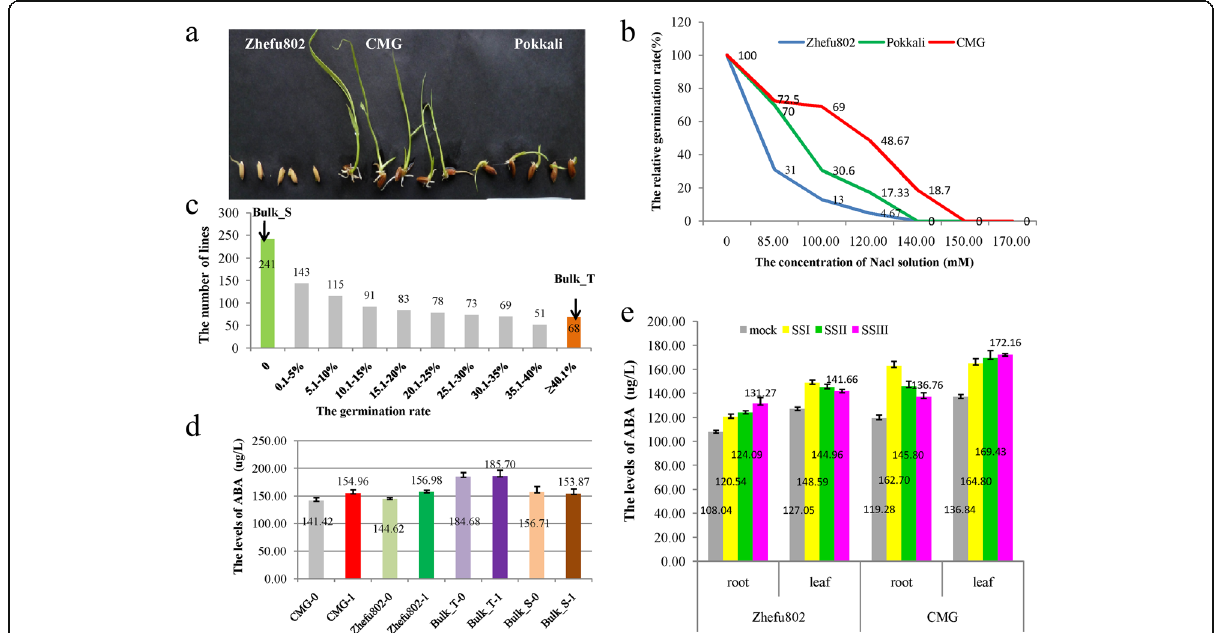
Fig. 1 The identification of salt tolerance and the assay of abscisic acid (ABA) in Zhefu802 and Changmaogu (CMG). a : The seedlings of CMG, Zhefu802, and Pokkali when the dry seeds were immersed in sea water (total salt:2%) at room temperature for 30 days; b : The germination tendencies of CMG, Zhefu802, and Pokkali at different NaCl concentrations; c : The germination rates of CMG, Zhefu802, and Pokkali in 0.12 mol/L NaCl solution; d : the ABA levels of both parents and two bulks at germination stage; e: the ABA levels in roots and leaves of CMG at different sampling points under salt